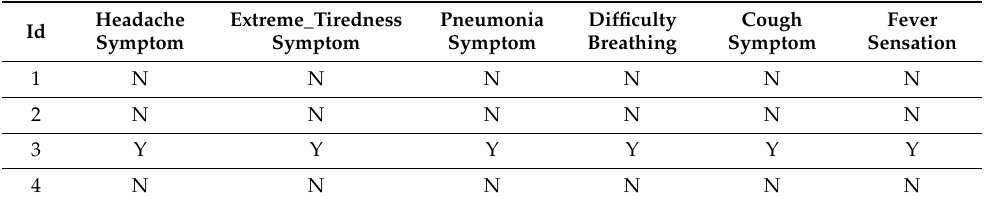
Table 8. Questionnaire answers.